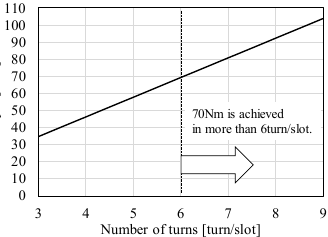
Figure 6. Relationship between output torque and number of turns.